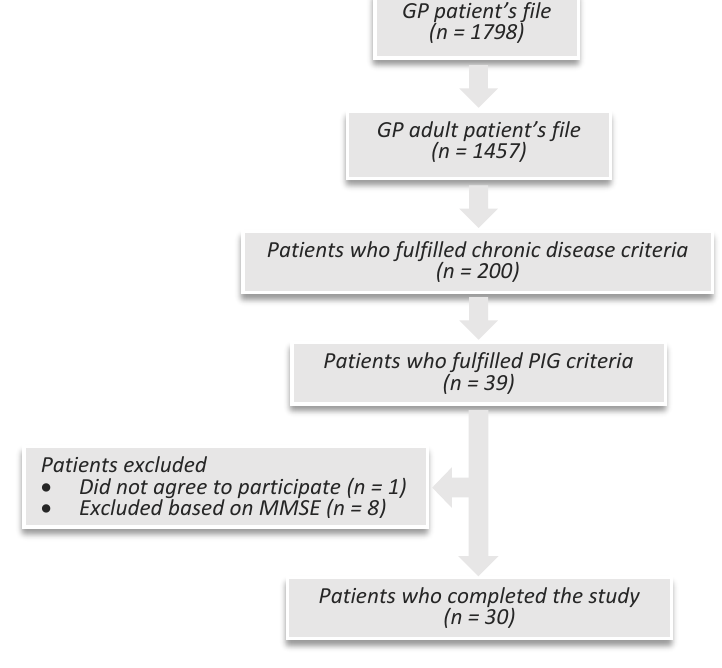
Figure 1. Study enrollment flowchart.